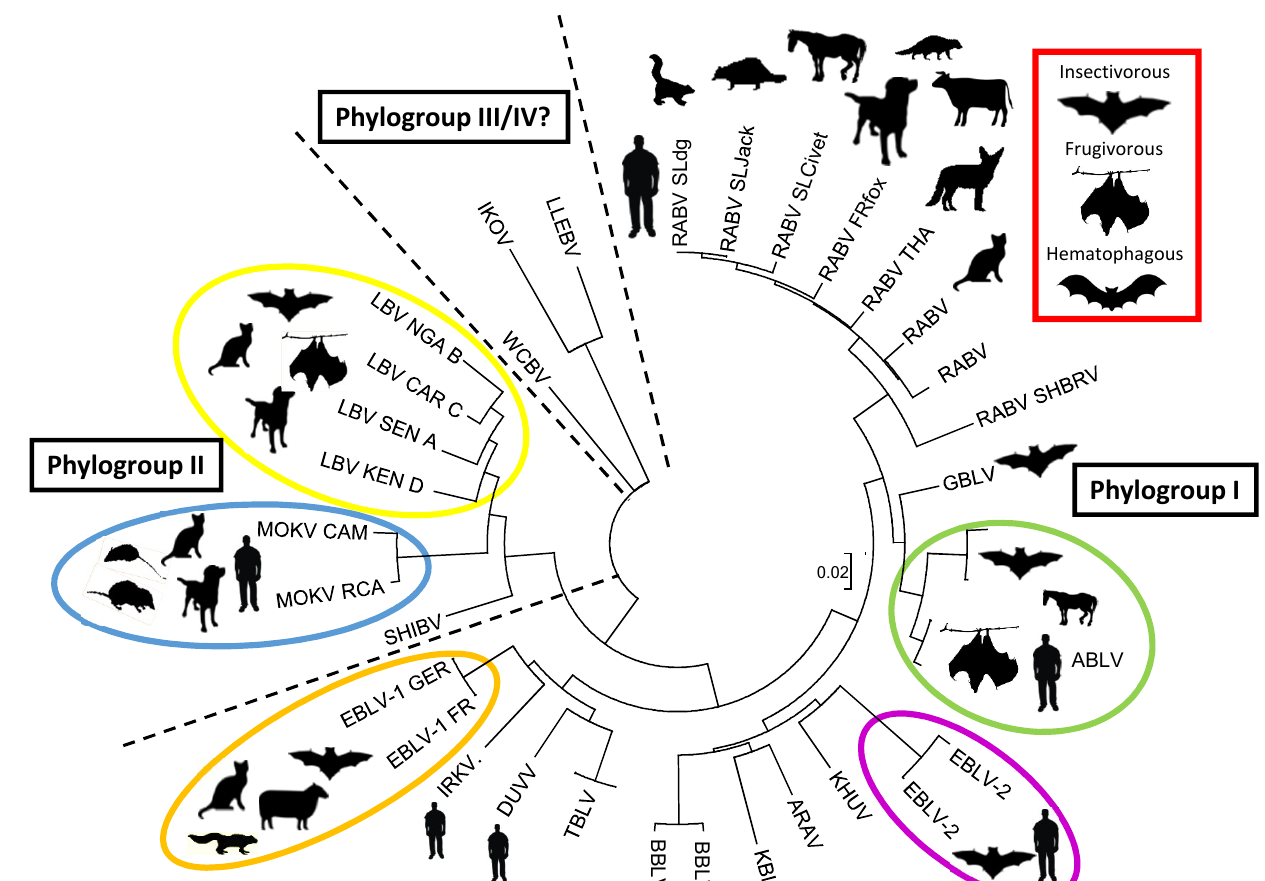
Figure 1. Phylogenetic relationships of the lyssaviruses. The phylogenetic tree is based on an alignment of a fragment of the lyssavirus nucleocapsid gene (450bp). The evolutionary history was inferred using the neighbor-joining method, with branch lengths in the same units as those of the evolutionary distances used to infer the phylogenetic tree. Evolutionary analyses were conducted using